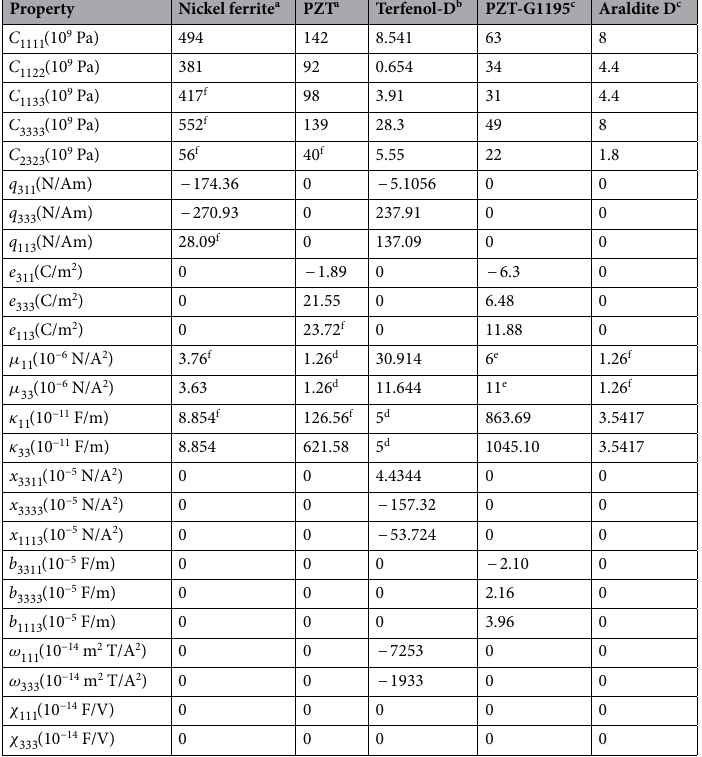
Table 2. Material properties of constituents. a The material properties of the nickel ferrite and PZT are obtained from Petrov et al. 43 . b The material properties of the Terfenol-D are obtained from Shen and Lin 30 . c The material properties of the PZT-G1195 and Araldite D are obtained from Lin and Muliana 31 . d The corresponding material properties are obtained from Kuo and Peng 44 . e The corresponding material properties are obtained from Veerannan and Arockiarajan 45 . f The corresponding material properties are